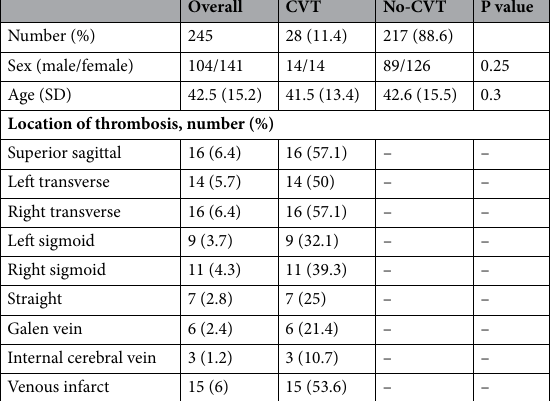
Table 1. Demographics, and the frequency of CVT-related findings in 245 evaluated patients.